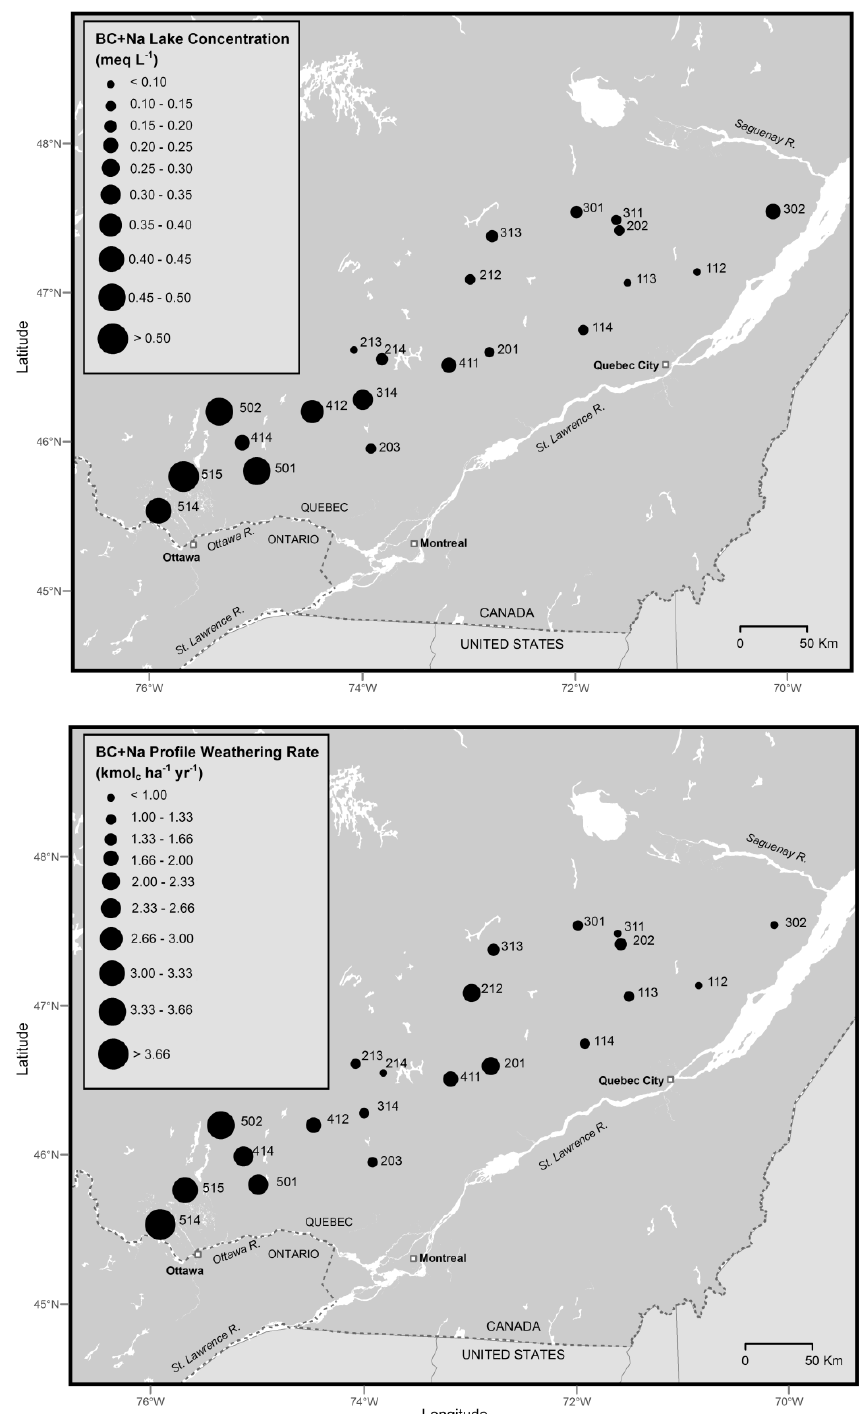
Fig. 2. Spatial variability in the BC+Na lake concentrations (upper panel) and in BC+Na PROFILE weathering rates (lower panel) for the 21 catchments